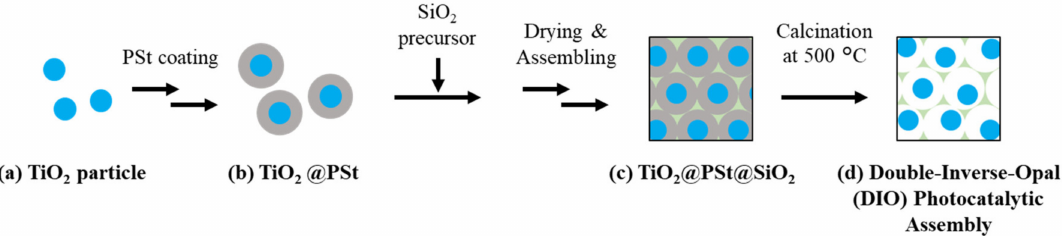
Figure 1. Schematic procedure of double-inverse-opal (DIO) structure with a combined component of TiO 2 particles and inverse opal SiO 2 frame. ( a ) Synthesis of TiO 2 core particles, ( b ) Polystyrene-coating of TiO 2 particles (TiO 2 @PSt), ( c ) Filling the interstices of assembled TiO 2 @PSt with SiO 2 (TiO 2 @PSt@SiO 2 ), and ( d ) Removal of polystyrene shell (double-inverse- opal photocatalytic